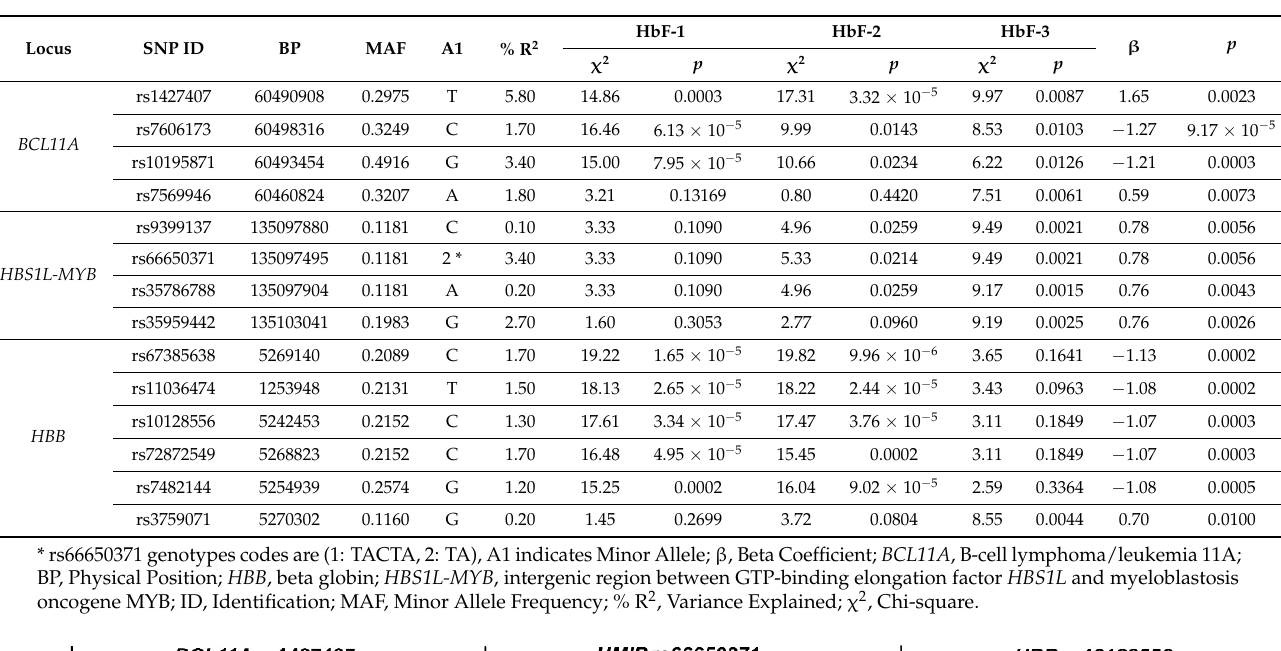
Table 1. Variants in BCL11A , HBS1L-MYB and HBB loci showing the most significant association with HbF in Kuwaiti patients with SCD.